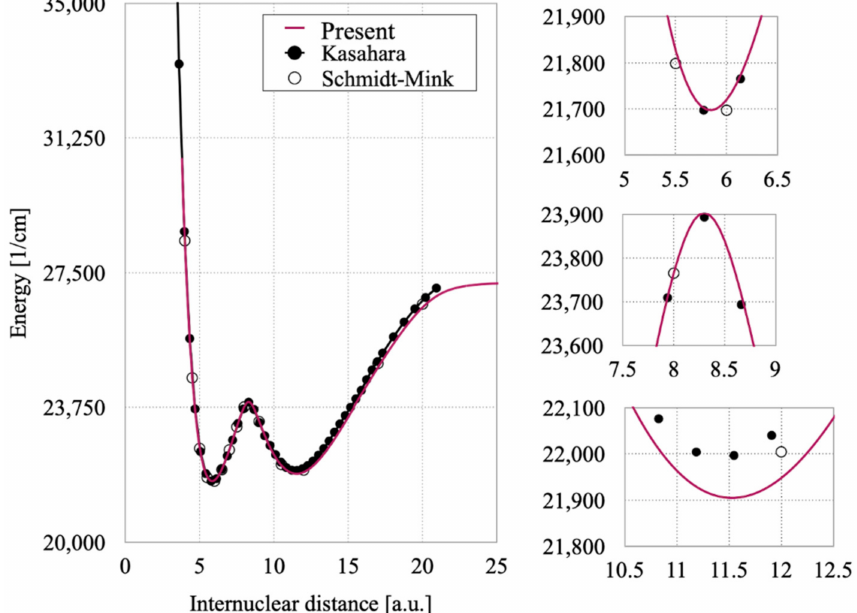
Figure 3. Comparisons of the potential curves of the 2 1 Σ u+ state between the present work and previously published results ( left ) with three close-up figures ( right ).